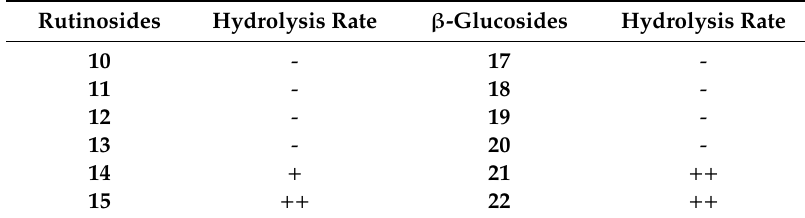
Table 2. Hydrolysis of transglycosylation products 10 – 23 by An Rut a